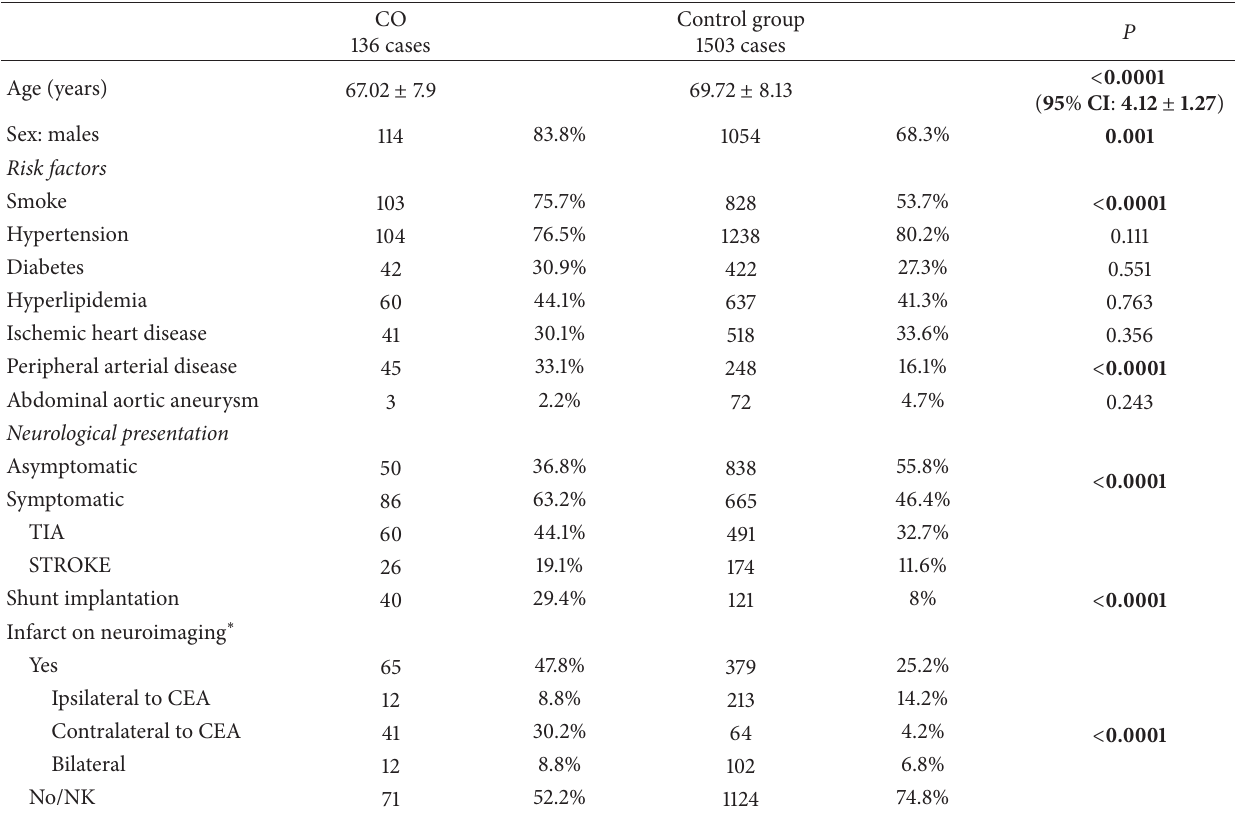
Table 1: Analysis of demographic factors in 1639 primary carotid